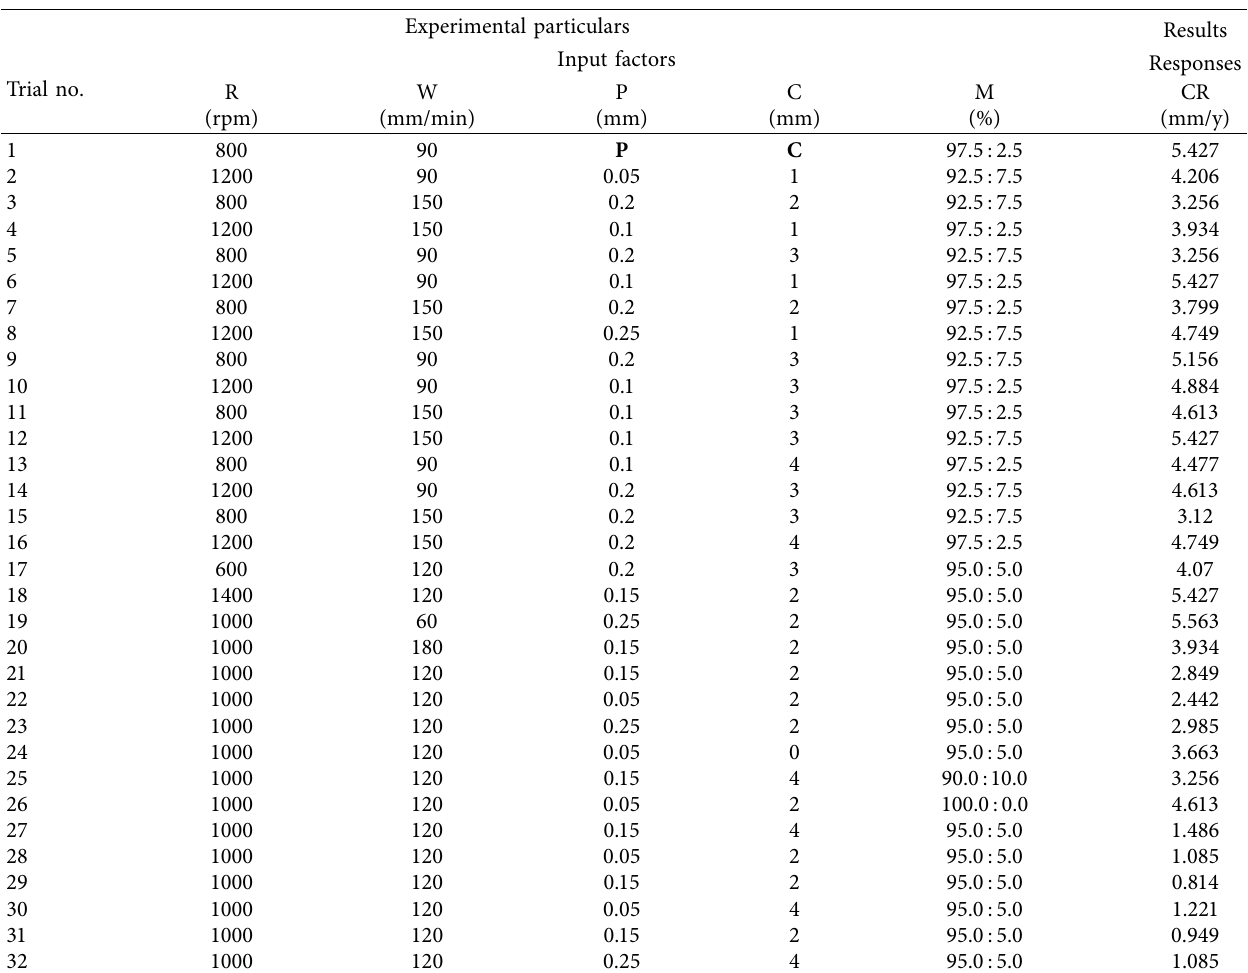
Table 9: Design matrix for corrosion rate. Experimental particulars Results